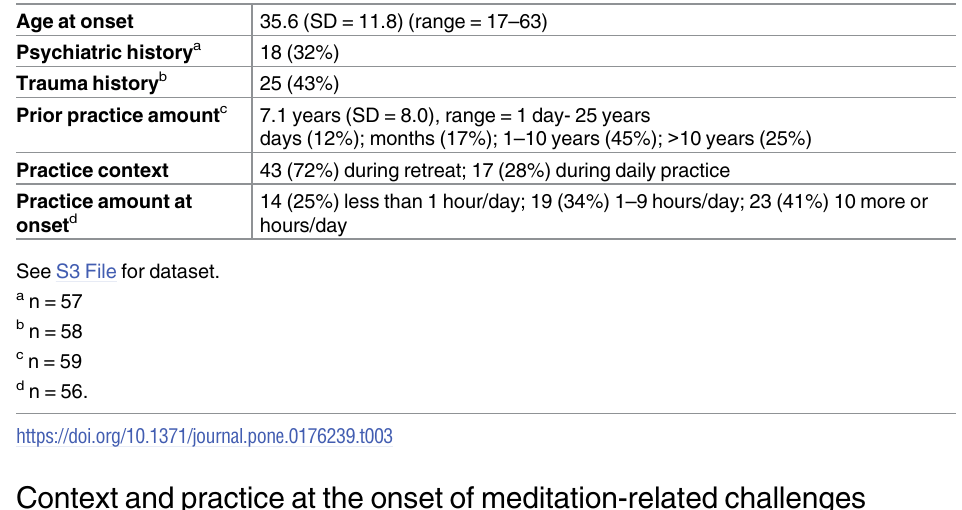
Table 3. Practitioner characteristics at onset of meditation-related